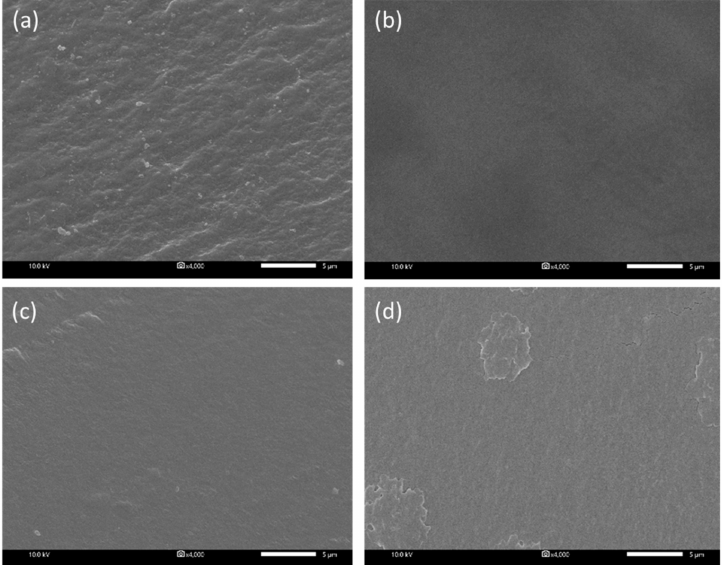
Figure 1. SEM images of cross-section area: ( a ) PVA membrane without MCM-41, ( b ) PVA membrane containing 2.5 wt.% MCM-41, ( c ) PVA membrane containing 5 wt.% MCM-41, and ( d ) PVA membrane containing 7.5 wt.%